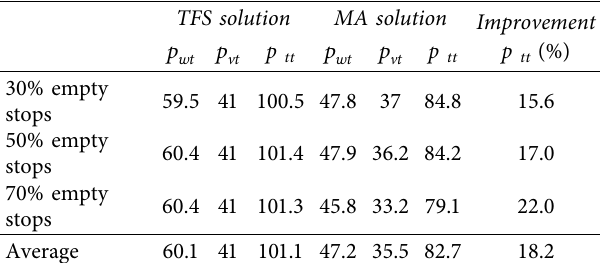
Table 10: Average passenger waiting, in-vehicle, and travel times for TFS, and the solution of the MA for the DRFS considering the large network. MA